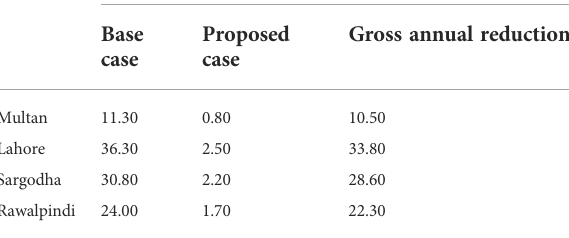
TABLE 10 GHG emission reduction potential of proposed PV projects at selected facility locations.